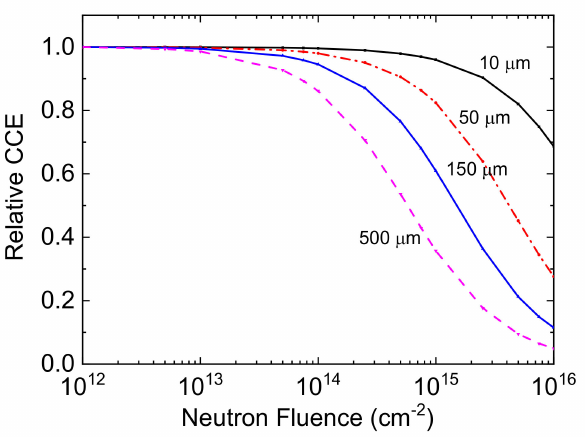
Figure 20. CCE relative to unirradiated sample vs. 14 MeV neutron fluence calculated using Equation